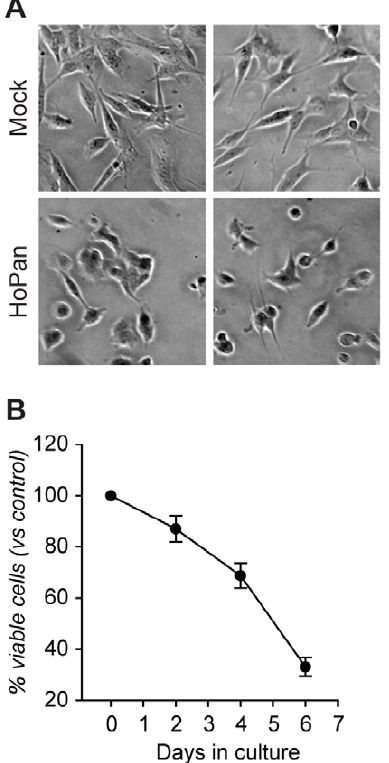
Figure 4. The morphology and viability of cultured human neuroblastoma SHSY-5Y cells is affected upon PANK inhibi- tion. SHSY-5Y cells were cultured in medium supplemented with 0,5 mM HoPan. ( A ) After 6 days in culture the cell morphology was visualized with an inverted microscope. Representative images of control (mock treated) and HoPan treated cells are shown. ( B ) Cell viability after 0–6 days in culture with HoPan was assayed by a Trypan blue exclusion test. Viability of control untreated cells was set as 100% at each time point.